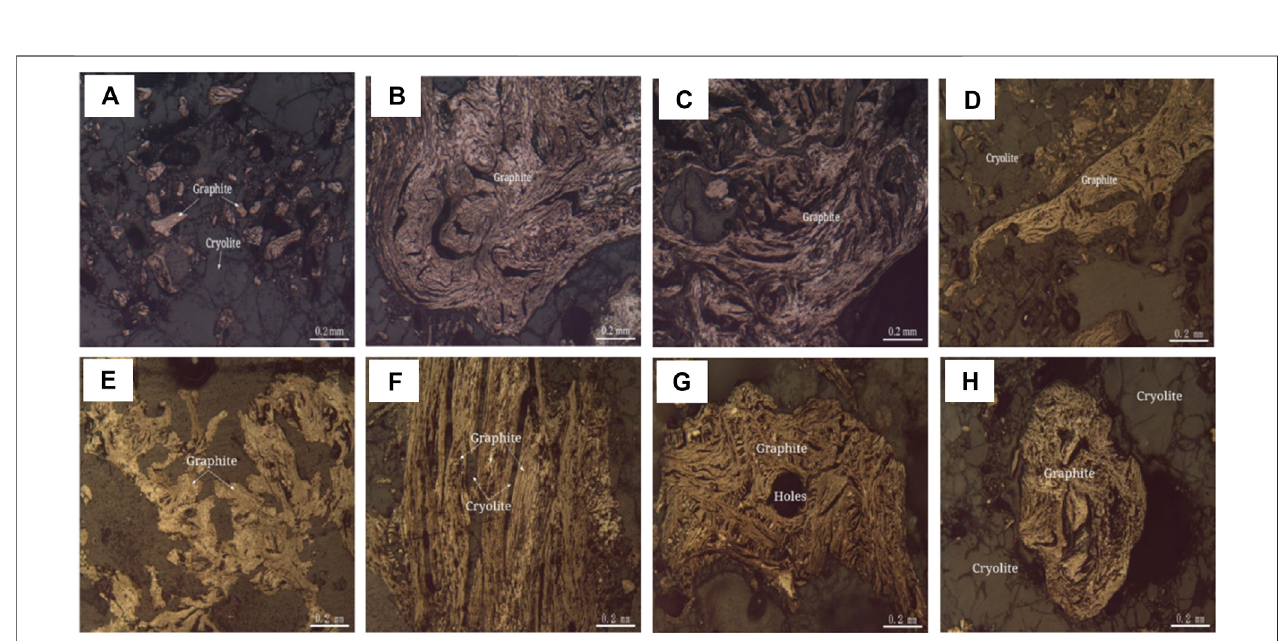
FIGURE 9 | Polarization microscope photo of graphite (Re fl ected Single Polarized Light). (A) Graphite aggregates are amorphous granules distributed between cryolitegrains. (B) Graphiteaggregatesaretwistedintoclumps. (C) Fibrousgraphiteistwisted. (D) Graphiteaggregatesareamorphousgranules. (E) Flake-likegraphite, aggregates are amorphous granular. (F) The fi brous graphite aggregates are bundled with cryolite fi lling between the bundled aggregates. (G) Graphite is twisted to be lumpy and camboidal polygonal. (H) Graphite aggregates are spherical.